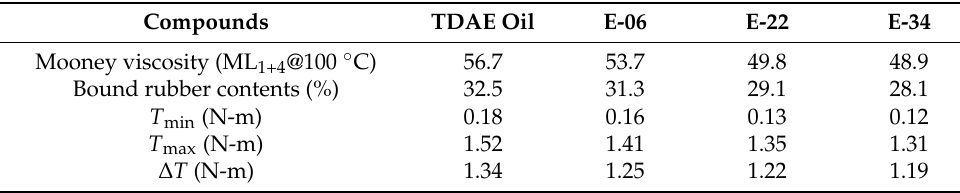
Table 5. Curing characteristics and Mooney viscosities of the compounds.